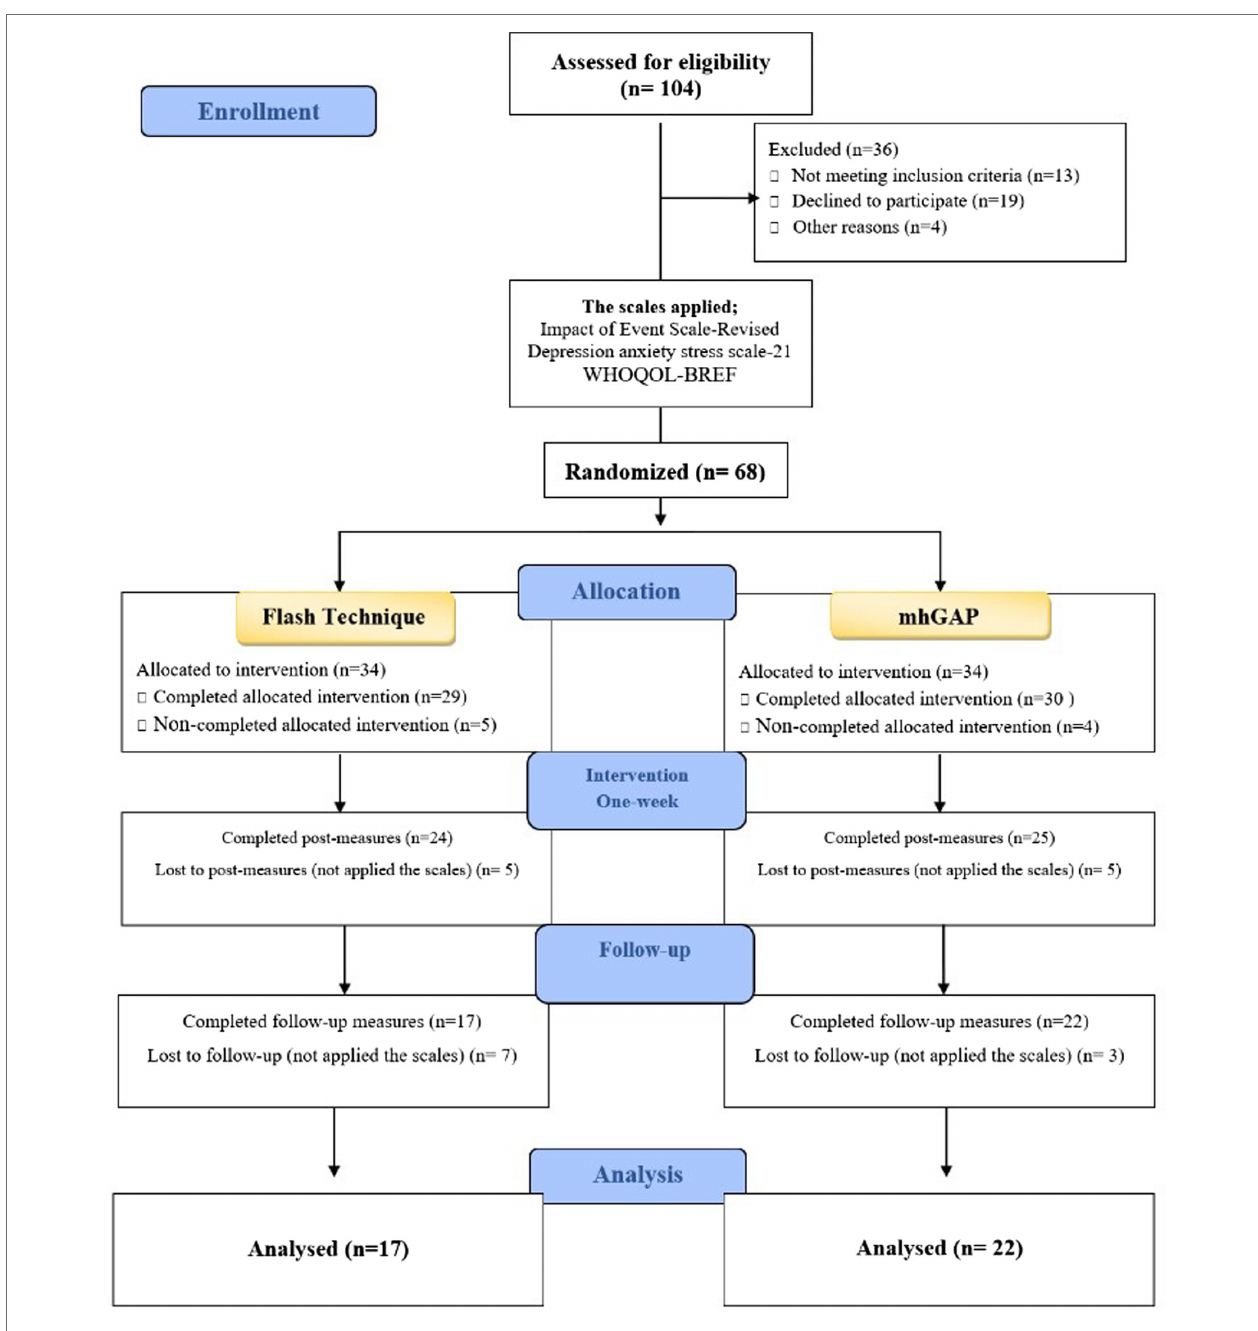
FIGURE 1 | Flowchart of participants through each stage of the